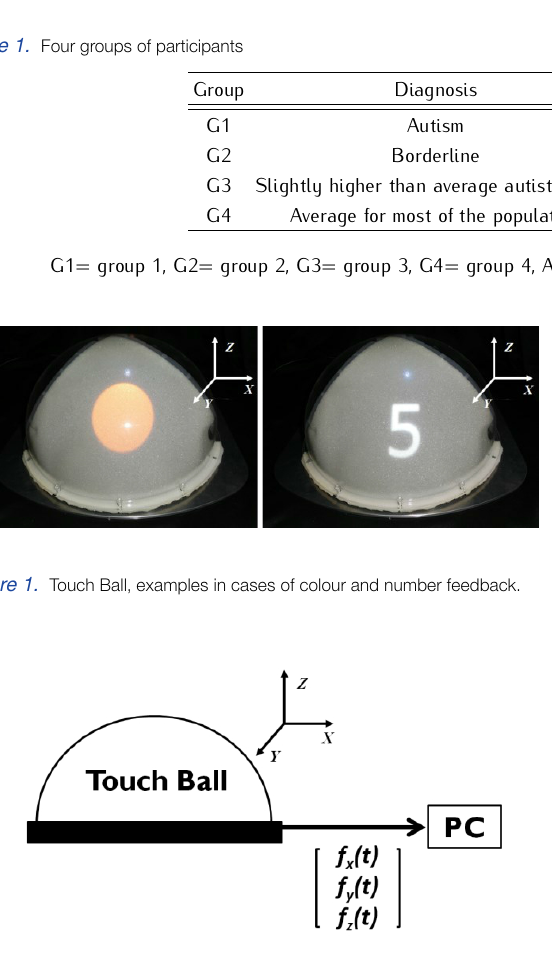
Figure 2. Block diagram of the force data collection.